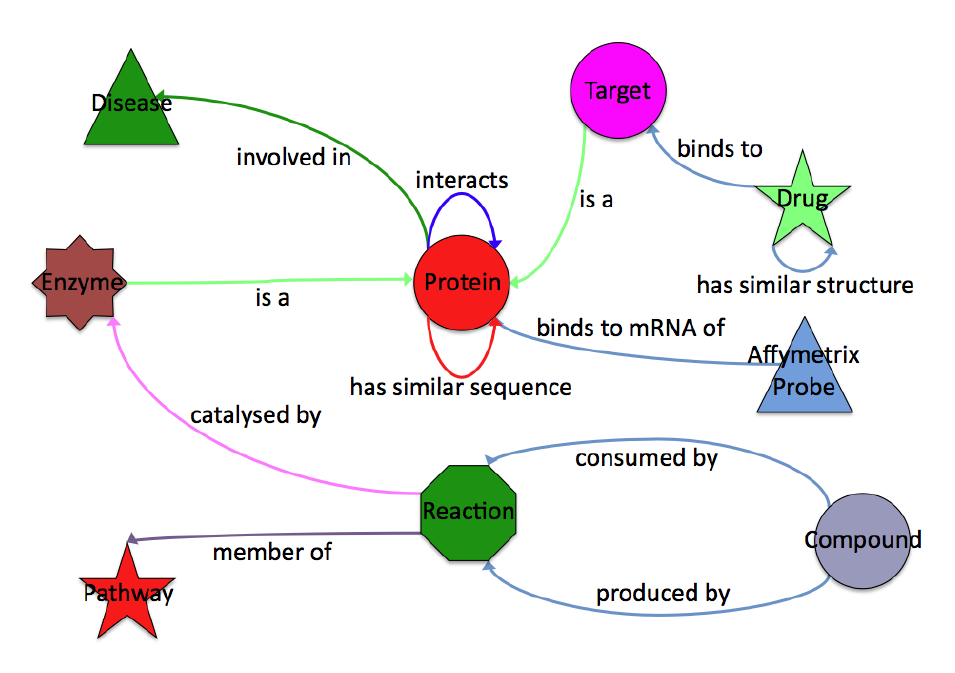
Figure 2: A subset of the metagraph of the Ondex drug repositioning dataset. Some ConceptClasses and RelationTypes have been removed for clarity. Drugs taken from DrugBank are actually of ConceptClass Compound but are called Drug here to avoid confusion with Compound concepts taken from